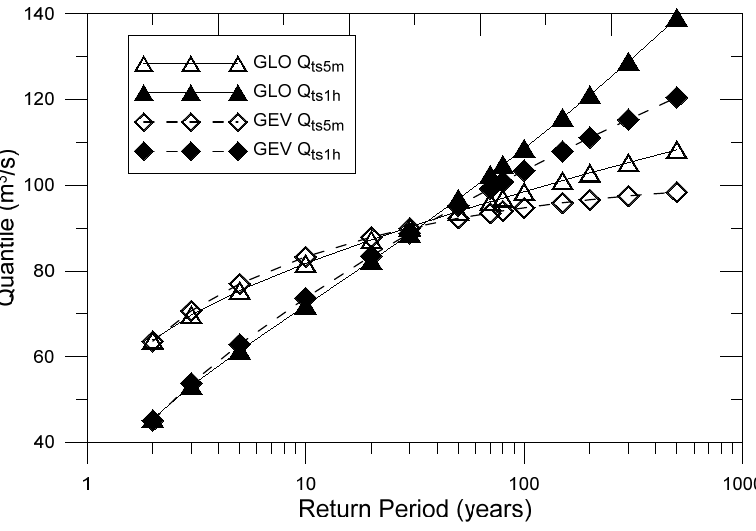
Figure 11. The estimated flood quantiles for the GLO and GEV models based on time step orders of 5 min and 1